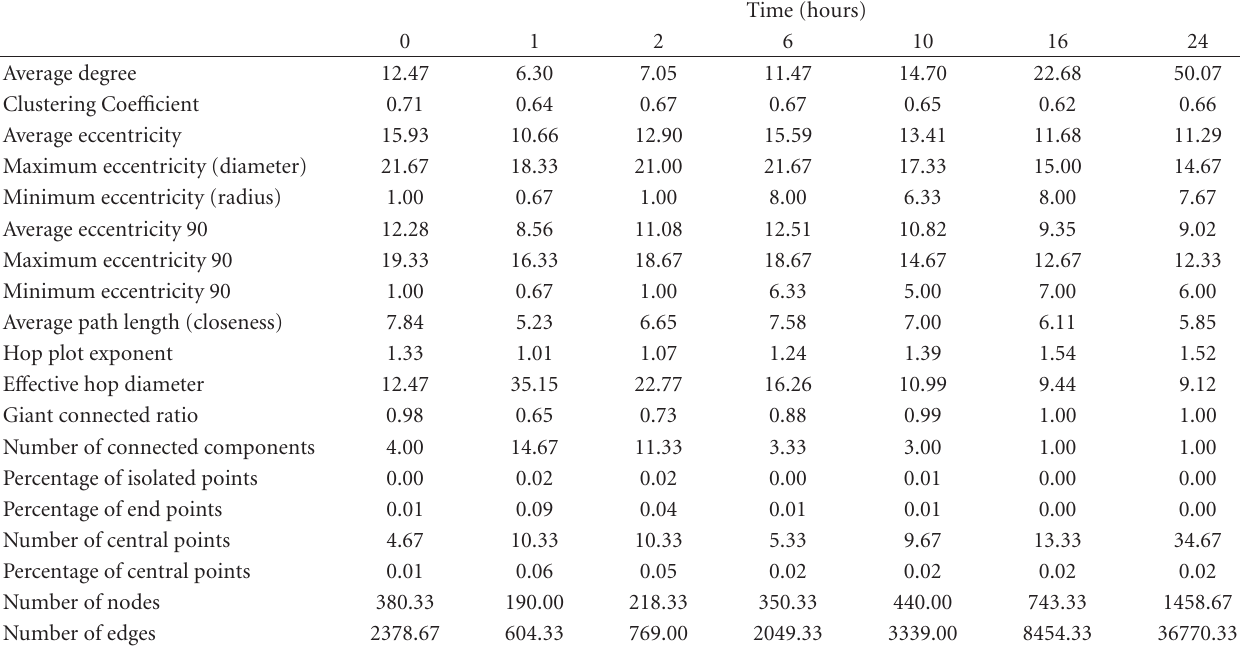
Figure 1: Macro- and micro scale compaction occurs over 24 hours of 3.0 × 10 5 cell/mL gels. hMSCs at a cell density of 3.0 × 10 5 cells/mL were embedded in 2mg/mL collagen I gels. Collagen I gels were fixed and stained for nuclei with SYTOX Green (a) Macroscale images of hydrogel compaction (Scale bar = 1cm). (b) Fluorescent image cross section of hMSC nuclei in collagen I gel (Scale bar = 100 μ m). Table 5: Quantitative metrics for 1 × 10 6 cells/mL collagen I hydrogel 24-hour